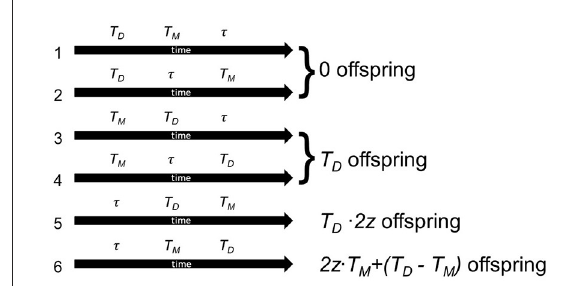
FIGURE1 Possible life histories in the simplified model with their corresponding lifetime number of viable offspring. T D is the time of death, T M time to first meeting, τ is the waiting time, at which an individual will start selfing, and z the viability of selfed offspring. In the first two cases (1 and 2), an individual dies before getting the chance to reproduce. In the next two cases (3 and 4), the individual never selfed, because it met a mating partner early. It releases all of its eggs as outcrossed eggs without inbreeding depression. Case 5 represents a case where an individual selfs at time τ , and then dies before meeting a mating partner. All its offspring are affected by inbreeding depression, but it was able to lay all its eggs. Finally, in case